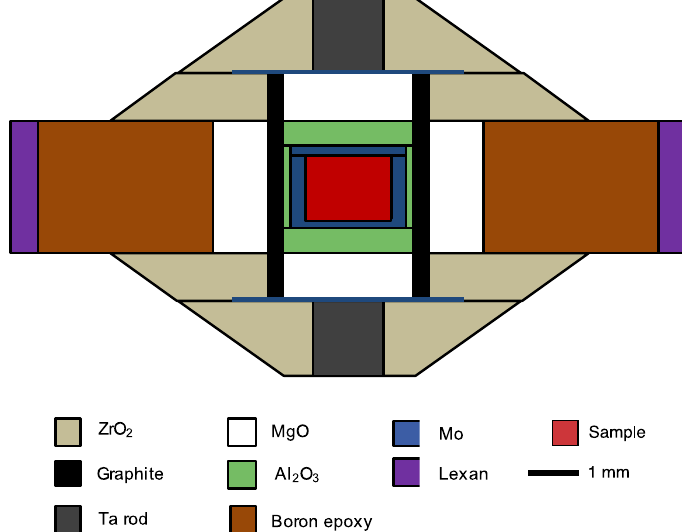
Figure 1. Cross section of the Paris-Edinburgh (PE) cell assembly used for X-ray microtomography experiments on silicate melts.